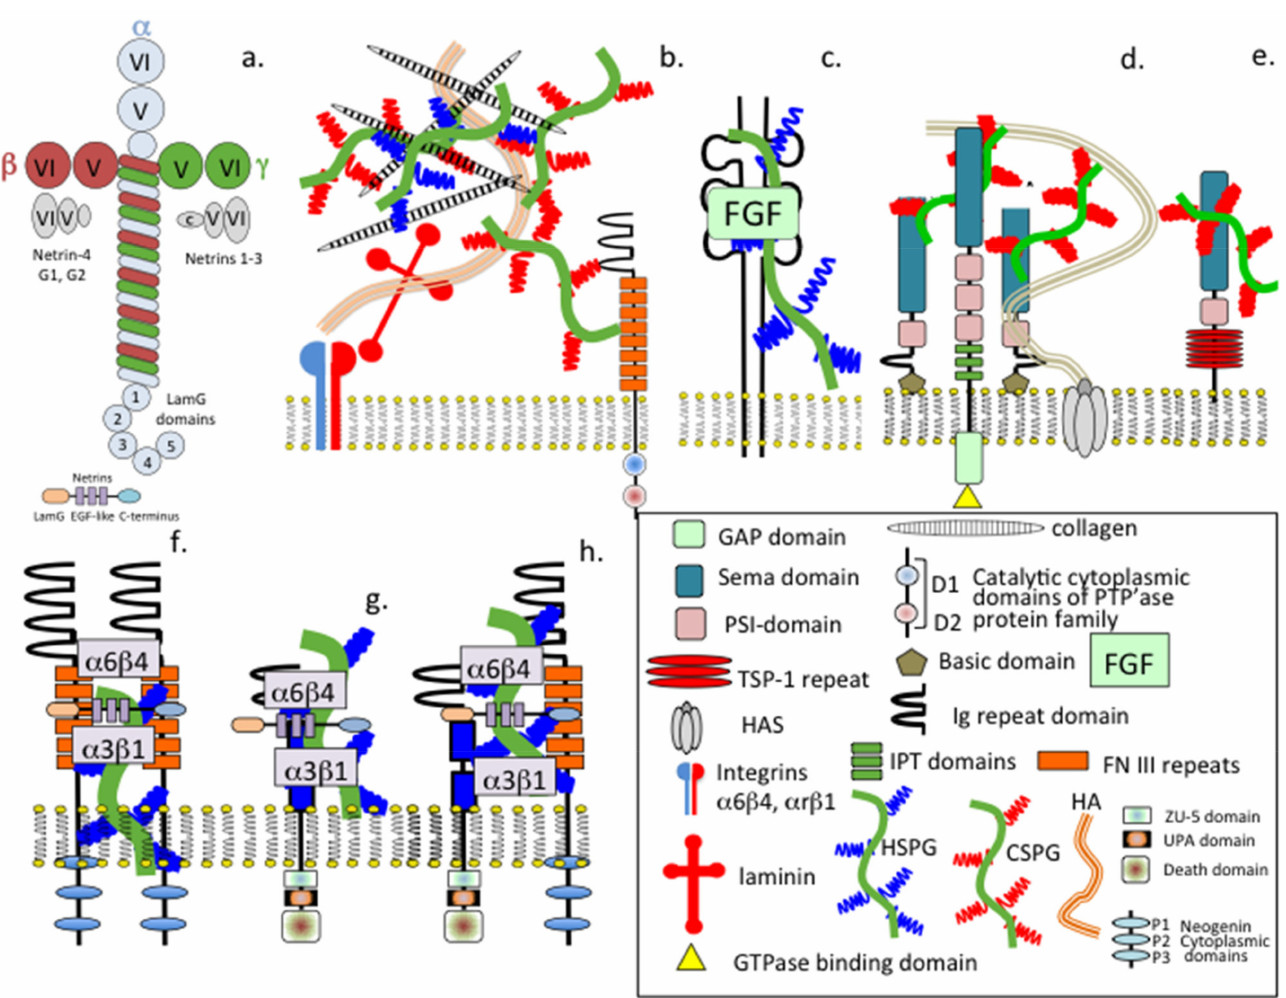
Figure 2. Schematic depiction of the structural organisation of generic laminin ( a ) and the related netrin neuroregulatory proteins ( b – h ) and depiction of how HS-PGs and CS-PGs interact with representative cell adhesion molecules and cellular receptors that promote neuron proliferation through growth factors sequestered by these proteoglycans ( b , c ) or facilitate attractive or repulsive neuroregulatory cues by semopharin3A-neuropilin ( d ) or semaphorin 5A ( e ). HS-PGs also participate in integrin-mediated dimerization interactions with cell adhesion molecules at the cell surface ( f ) and in interactions with netrin-1 and UNC-5A ( g ) and UNC5A-Neogenin/DCC netrin interactions ( h